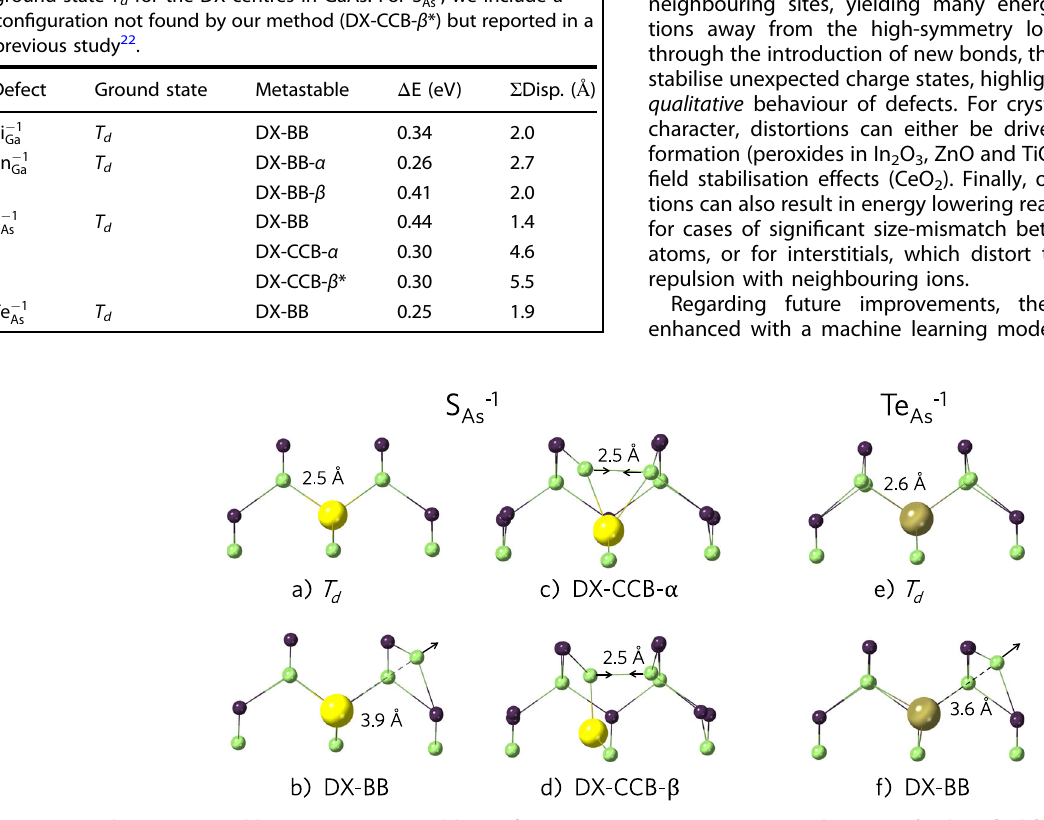
and Te (cid:1) 1 in GaAs. As As